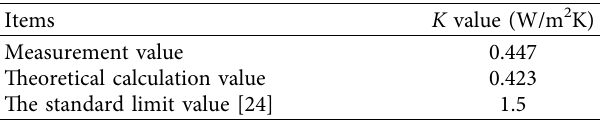
Table 5: Comparison among theoretical value and measured value and standard limit value.